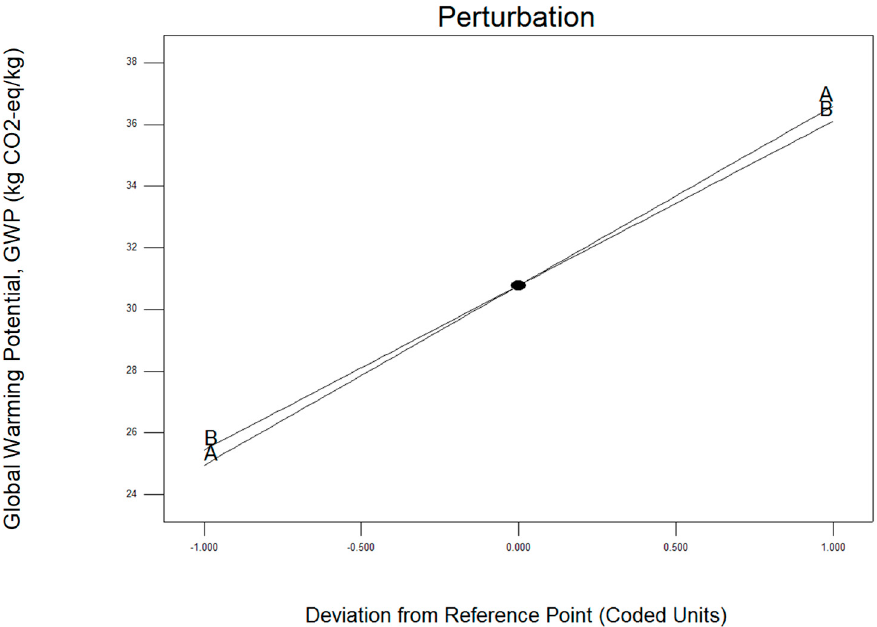
Figure 7. Perturbation plotted graph as a correlation of ( A ) operating temperature and ( B ) holding time for global warming potential, GWP.